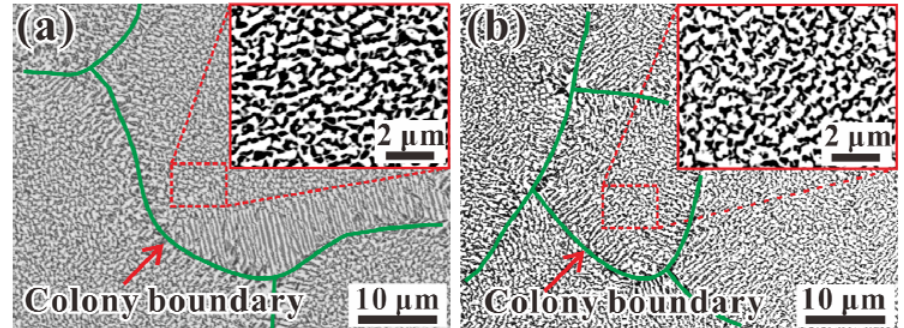
Fig. 8 Microstructures of the 3D-printed Al 2 O 3 /GdAlO 3 /ZrO 2 eutectic ceramic before and after the annealing treatment: (a) as-deposited microstructure and (b) annealed microstructure.